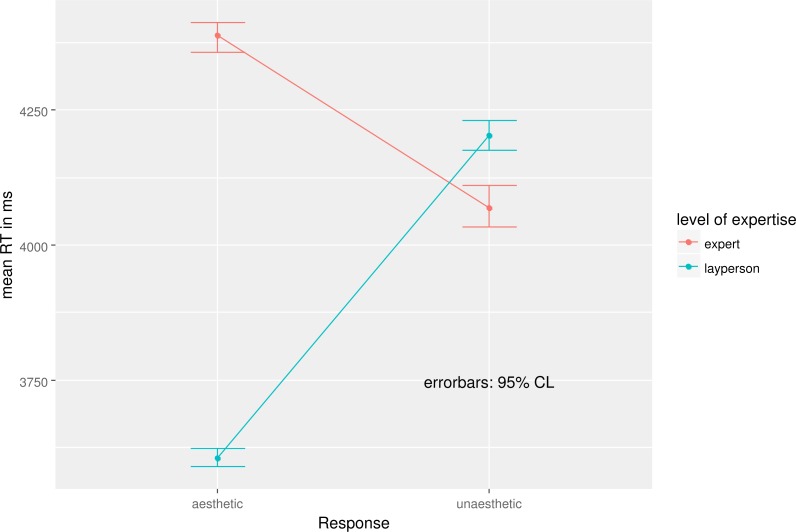
Trimmed means RT in ms as a function of level of expertise and response.